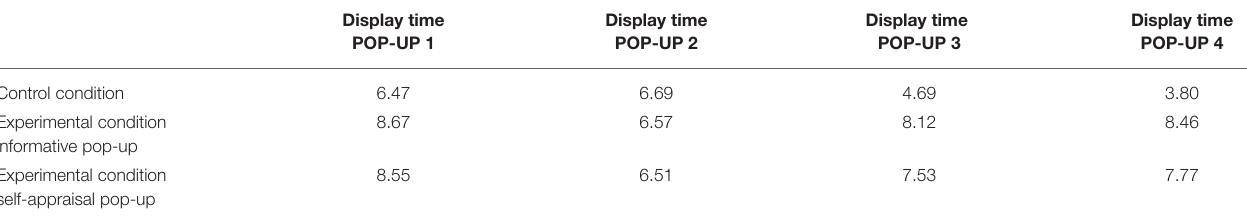
Display time POP-UP 1